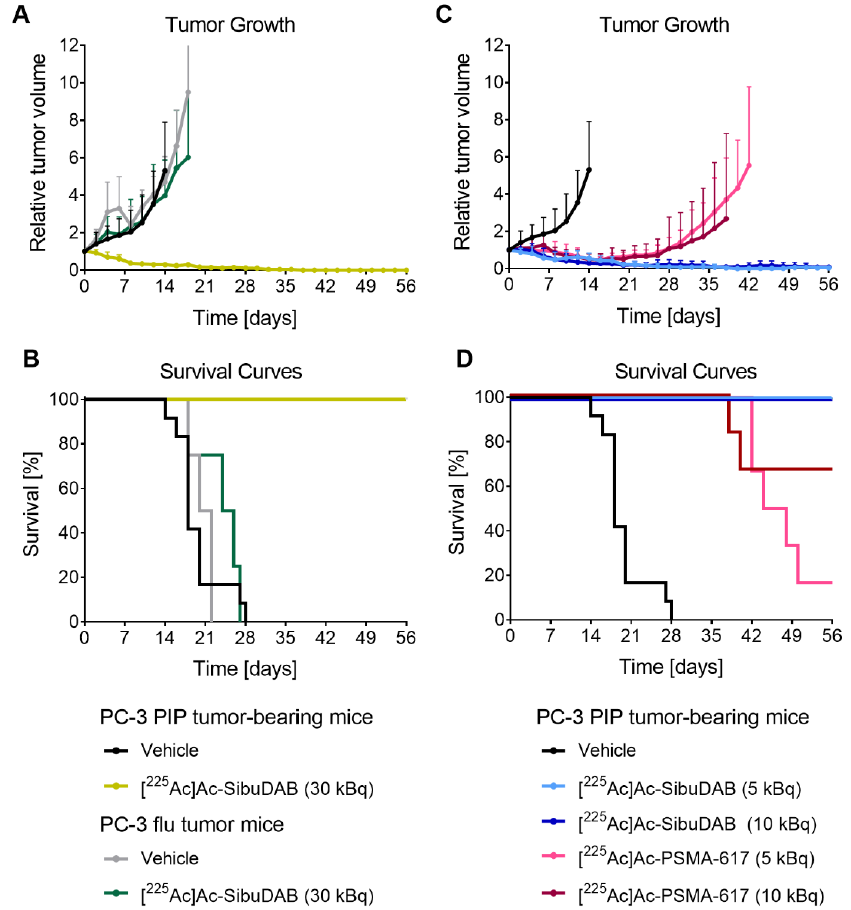
Figure 6. ( A , B ) PSMA-specific treatment efficacy of [ 225 Ac]Ac-SibuDAB assessed in mice with PSMA-positive PC-3 PIP or PSMA-negative PC-3 flu tumors injected with either vehicle or 30 kBq radioligand. ( C , D ) Comparison of the therapeutic efficacy of [ 225 Ac]Ac-SibuDAB and [ 225 Ac]Ac-PSMA-617 (5 or 10 kBq) in PSMA-positive PC-3 PIP tumor-bearing mice. ( A , C ) Relative tumor growth shown until the first mouse of the respective group reached an endpoint; ( B , D ) Kaplan–Meier plots showing the survival curves of mice of each group. The data of the PC-3 PIP tumor-bearing control mice were previously published by Borgna & Deberle et al. Mol Pharm 2022 [17] (Copyright 2022, American Chemical Society).